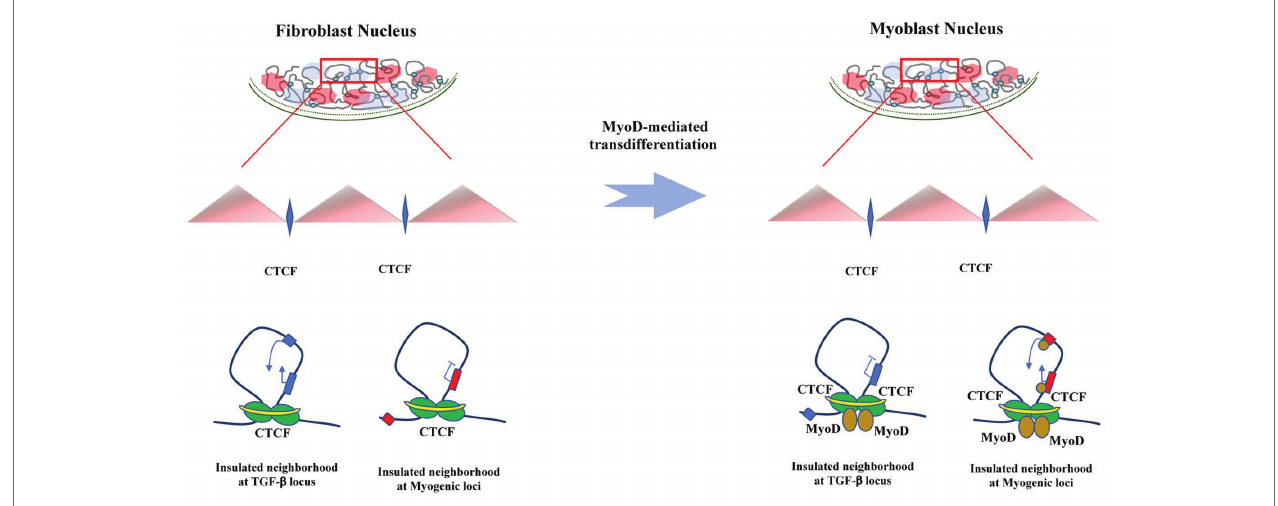
FIGURE 2 | MyoD dependent trans-differentiation drives changes in chromatin interaction. Schematic representation of chromatin changes that MyoD drives during somatic reprogramming toward trans-differentiation. While MyoD erases the cell of origin transcriptional program by altering insulated neighborhoods that allow – among many others – TGF- β promoter-enhancer contacts in fibroblasts, it also activates skeletal myogenesis through reconfiguration of chromatin interactions that involves cis -regulatory and structural genomic elements and temporally precedes transcriptional regulation of muscle